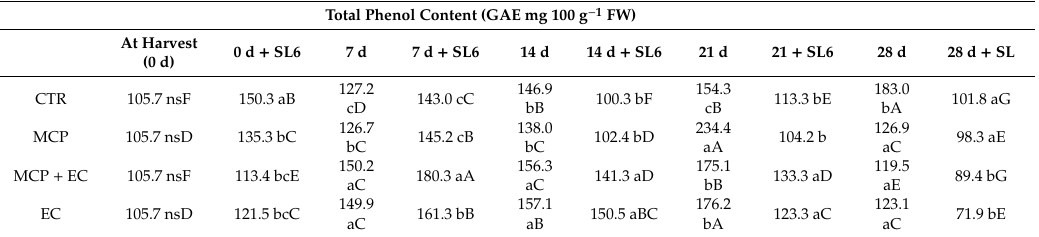
Table 3. Total phenol content (TPC, expressed as gallic acid equivalents (GAE, mg) per 100 g fresh weight (FW) of four di ff erent treatments, CTR, MCP, MCP + EC, and EC.